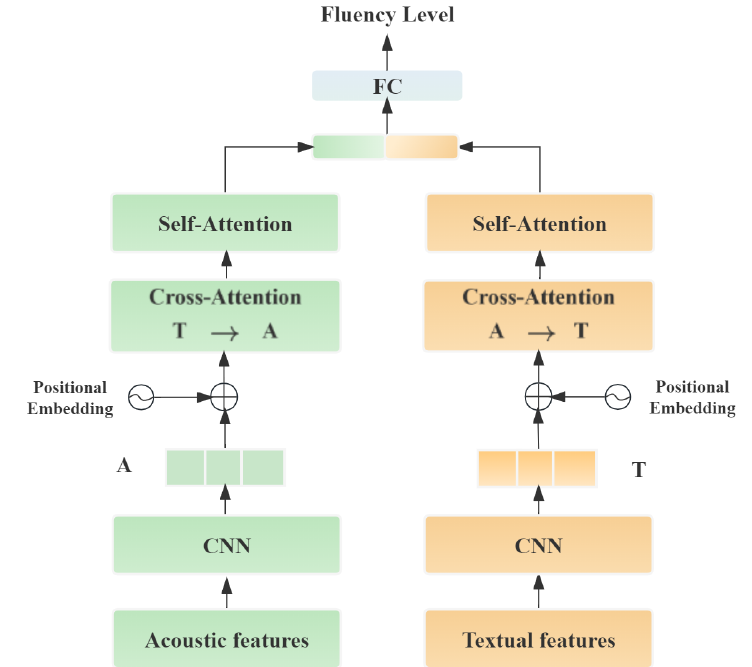
Figure 3. The architecture of the multimodel